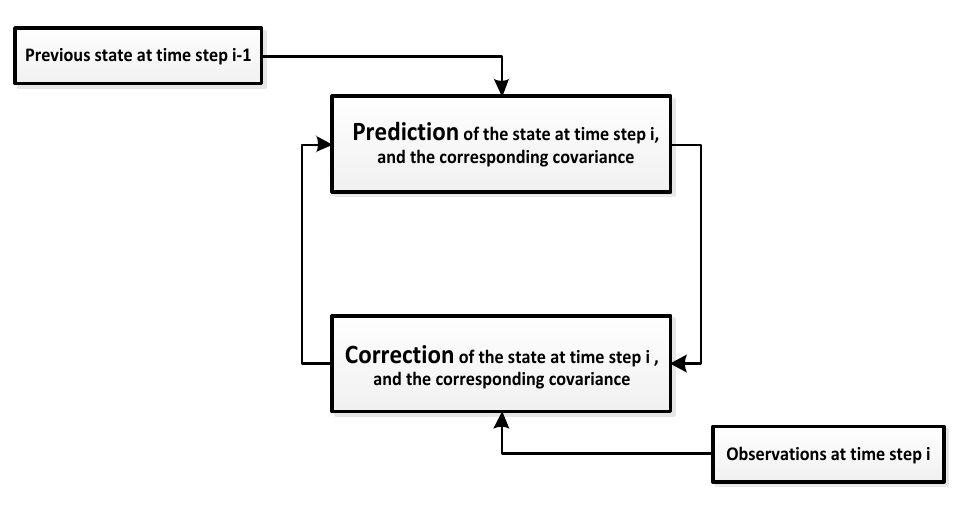
Figure 7. Kalman filter cycle.